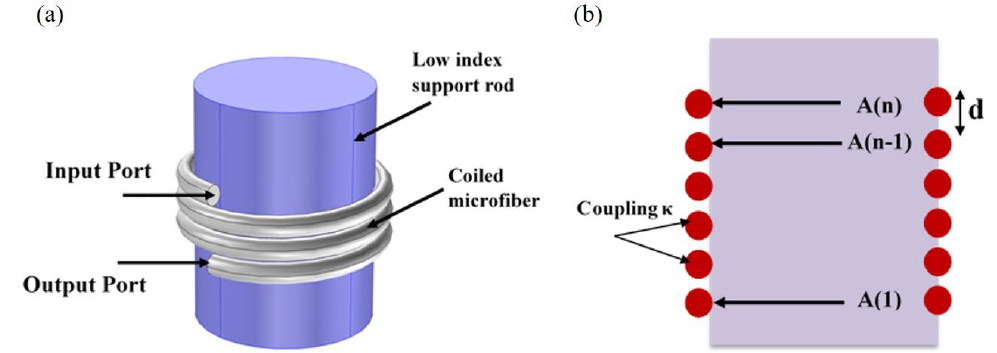
Figure 20. Microcoil resonator ( a ) Schematic of the resonator: a MF coiled around a solid cylindrical rod. ( b ) Cross